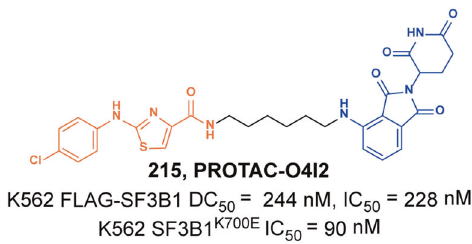
Fig. 68 The representative PROTAC targeting SF3B1